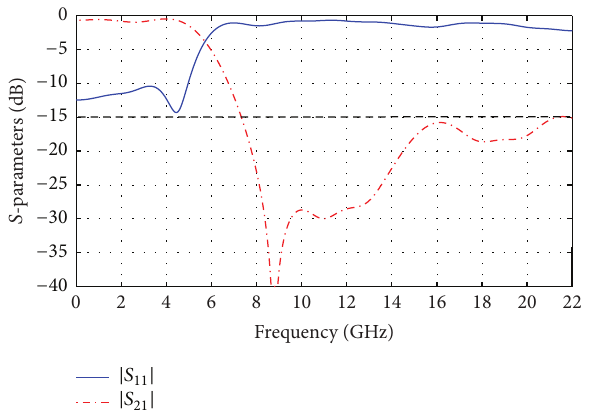
Figure 3: Magnitude of the filter scattering parameters versus frequency.